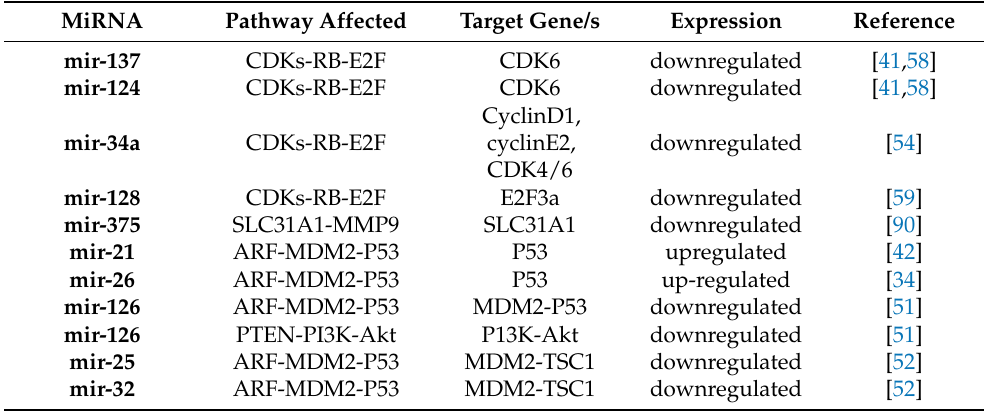
Table 1. The targets of multiple miRNAs on altered pathways in